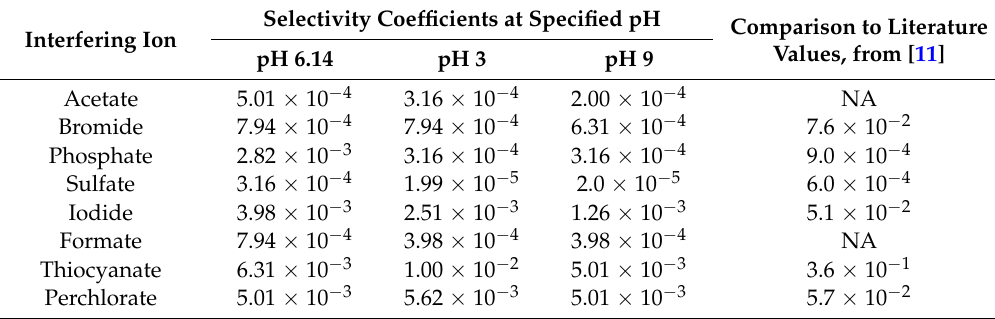
Table 1. Selectivity coefficients for nitrate ion selective electrodes.